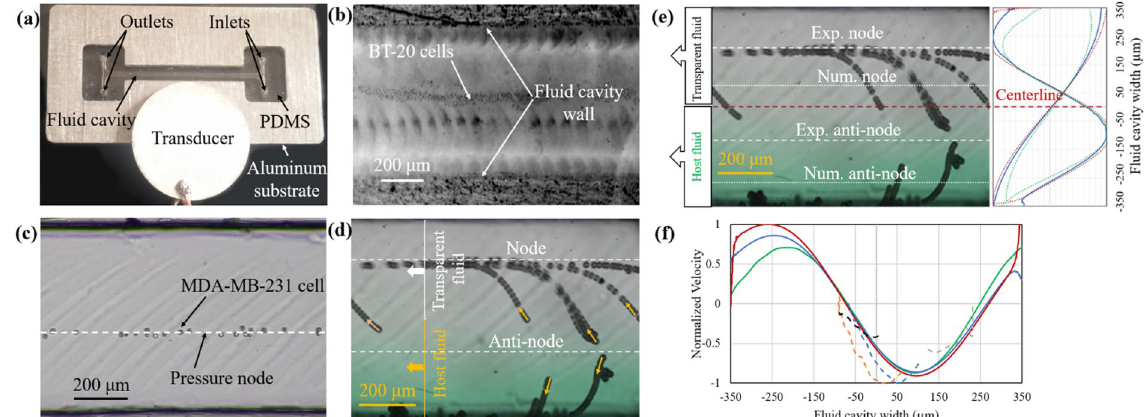
Figure 7. Experimental set-up and the testing results for acoustophoretic actuation of breast cancer cells and bead particles. ( a ) The fabricated hybrid aluminum-PDMS microchannel, ( b ) acoustic actuation of BT-20 cancer cells (average diameter: 17.5 µm) toward the nodal line in the aluminum microchannel, ( c ) acoustic actuation of MDA-MB-231 cancer cells toward the nodal line in the hybrid aluminum-PDMS, ( d ) acoustic actuation of polystyrene particles and their trajectory in direction of thin yellow arrows. ( e ) the numerical and experimental node and anti-node positions relative to the centerline. ( f ) normalized velocity along the width of the fluid